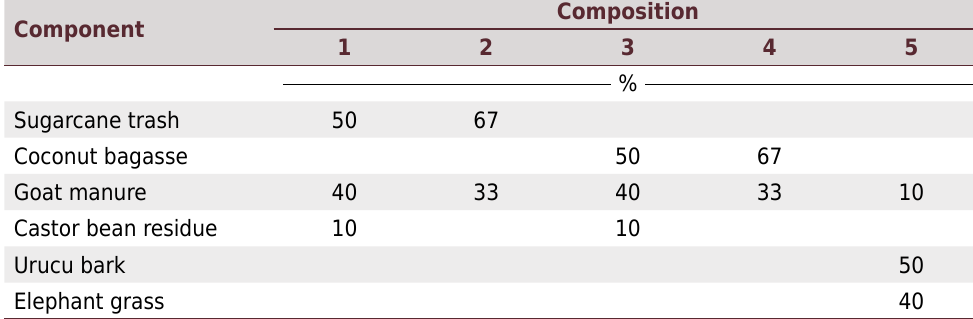
Table 1. Composition of residues in the mounds for preparation of the composts used in the experimental area